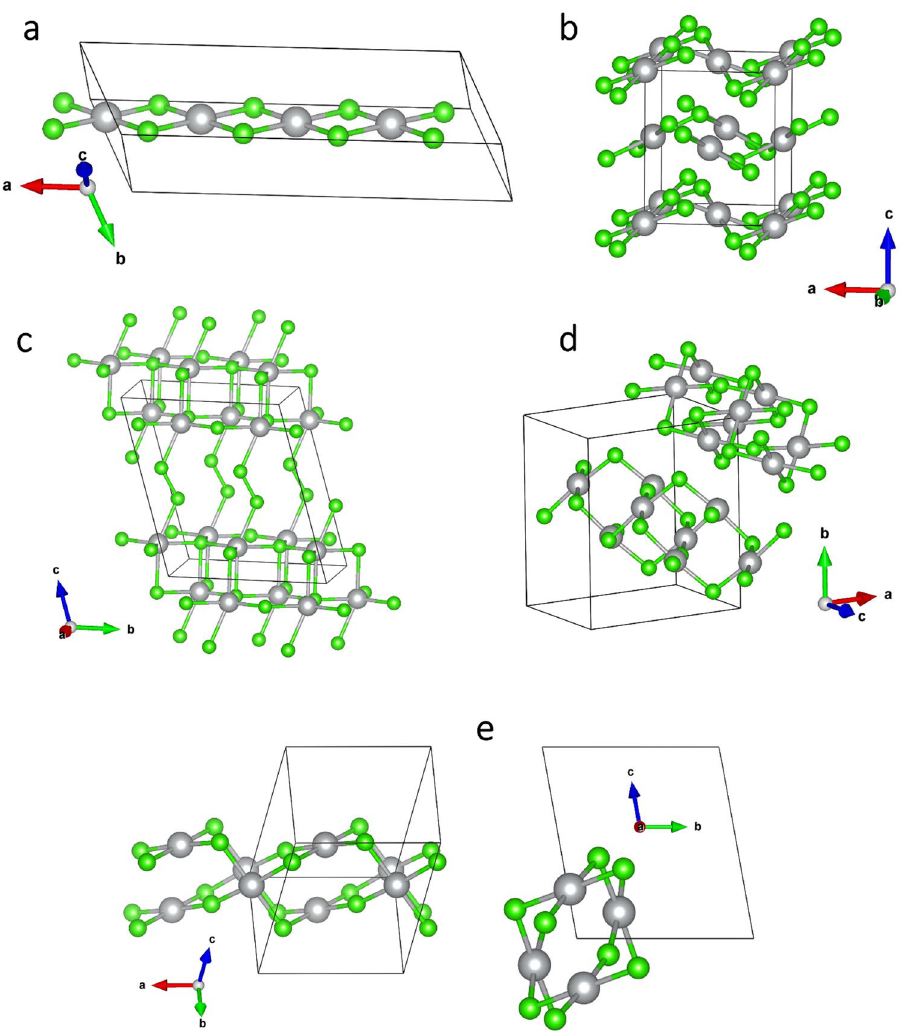
Figure 1. Selected structures of AgCl 2 candidate polymorphs. (a) CuCl 2 -type, (b) AgF 2 -type, (c) Ag(I)r, (d)